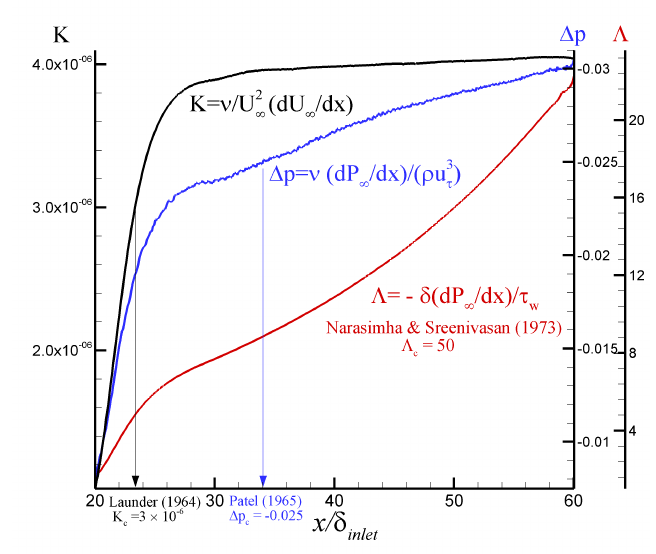
Figure 5. Streamwise variation of K , ∆ p , and Λ